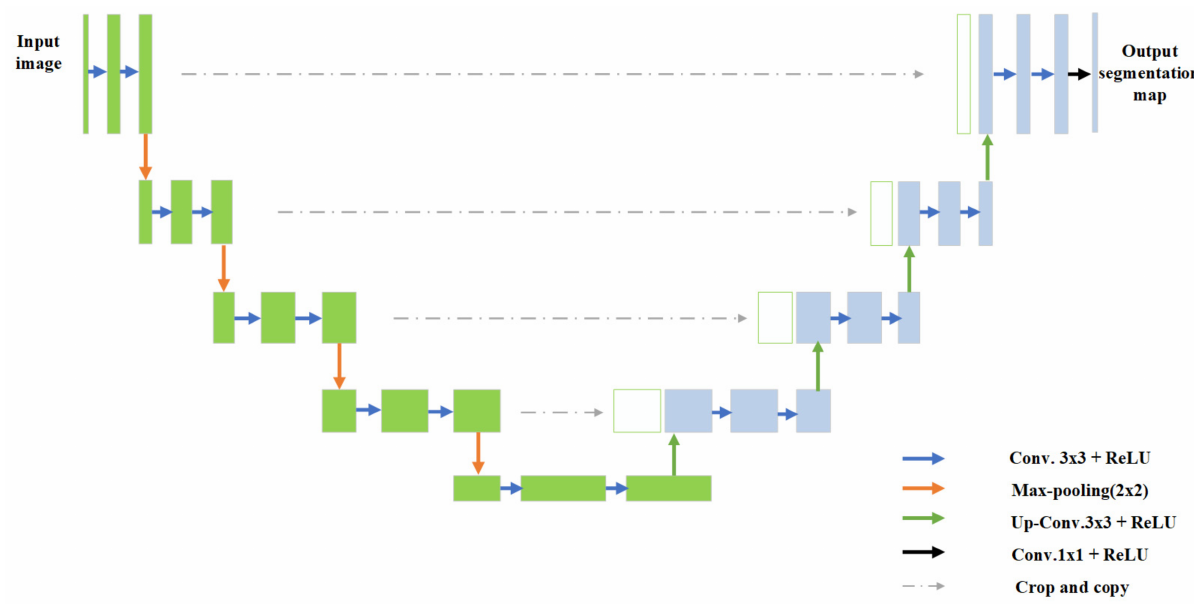
Figure 1. The structure of the